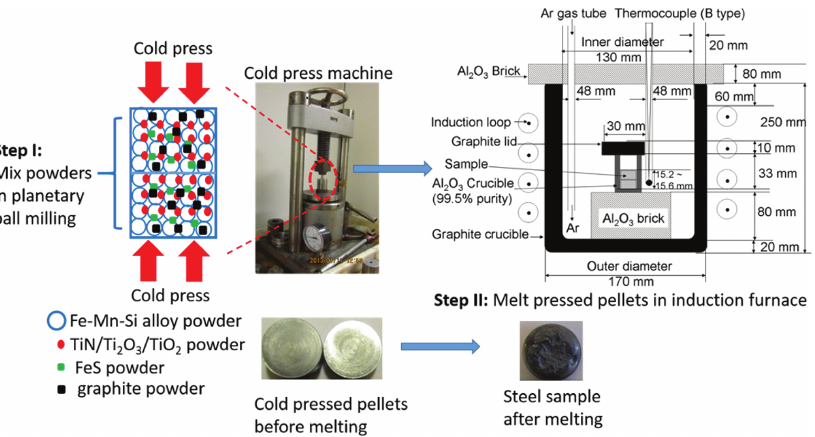
Figure 3: Schematic illustration of pre- paration method pf steel sample with TiN and Ti-oxides additions. This work is done by the present